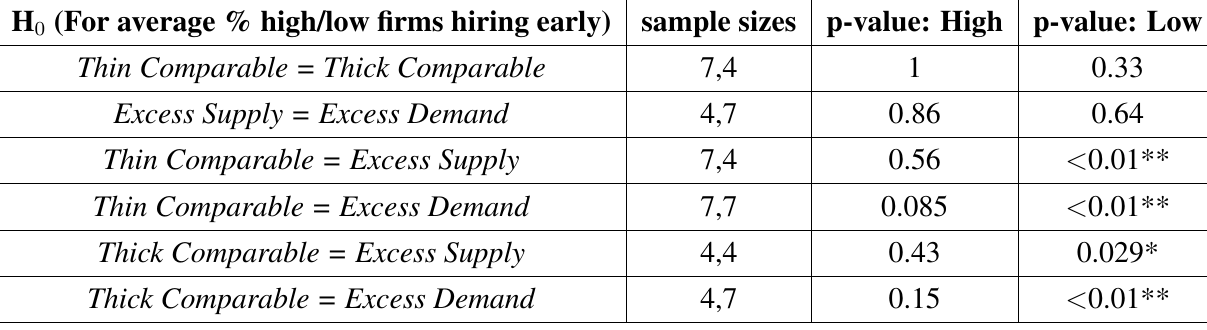
Table 7. Testing equivalence of high firm and low firm early hiring percentages in the last five